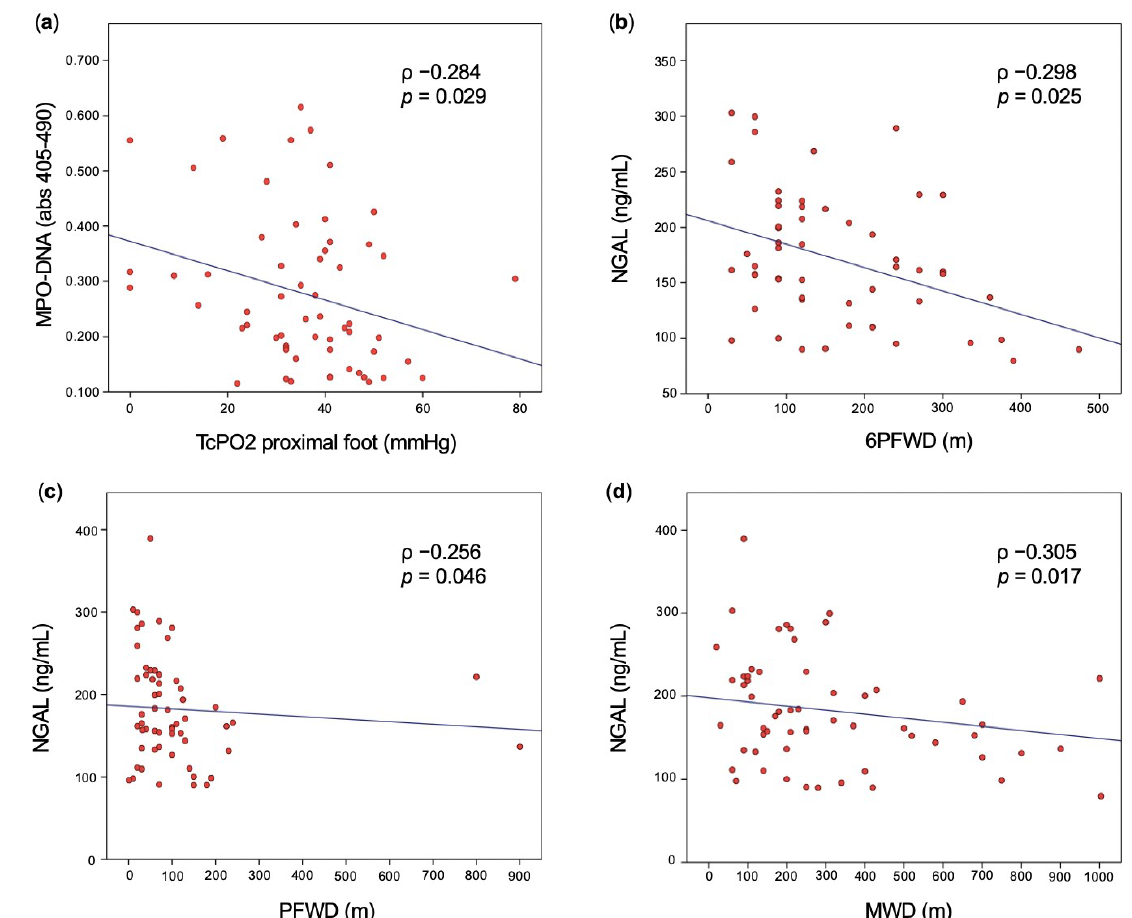
Figure 2. Scatter plot. Linear correlation analyses showing significant correlation between markers of neutrophil activation and vascular tests in patients with symptomatic chronic PAD: MPO–DNA and TcPO2 on proximal foot ( a ); NGAL and 6PFWD ( b ), PFWD ( c ), and MWD ( d ). Extreme outliers (95th percentile) may not be displayed in the figures. MWD: maximal walking distance; NGAL: neutrophil gelatinase-associated lipocalin; PFWD: pain-free walking distance; 6MWD: 6-min maximal walking distance; 6PFWD: 6-min pain-free walking distance.